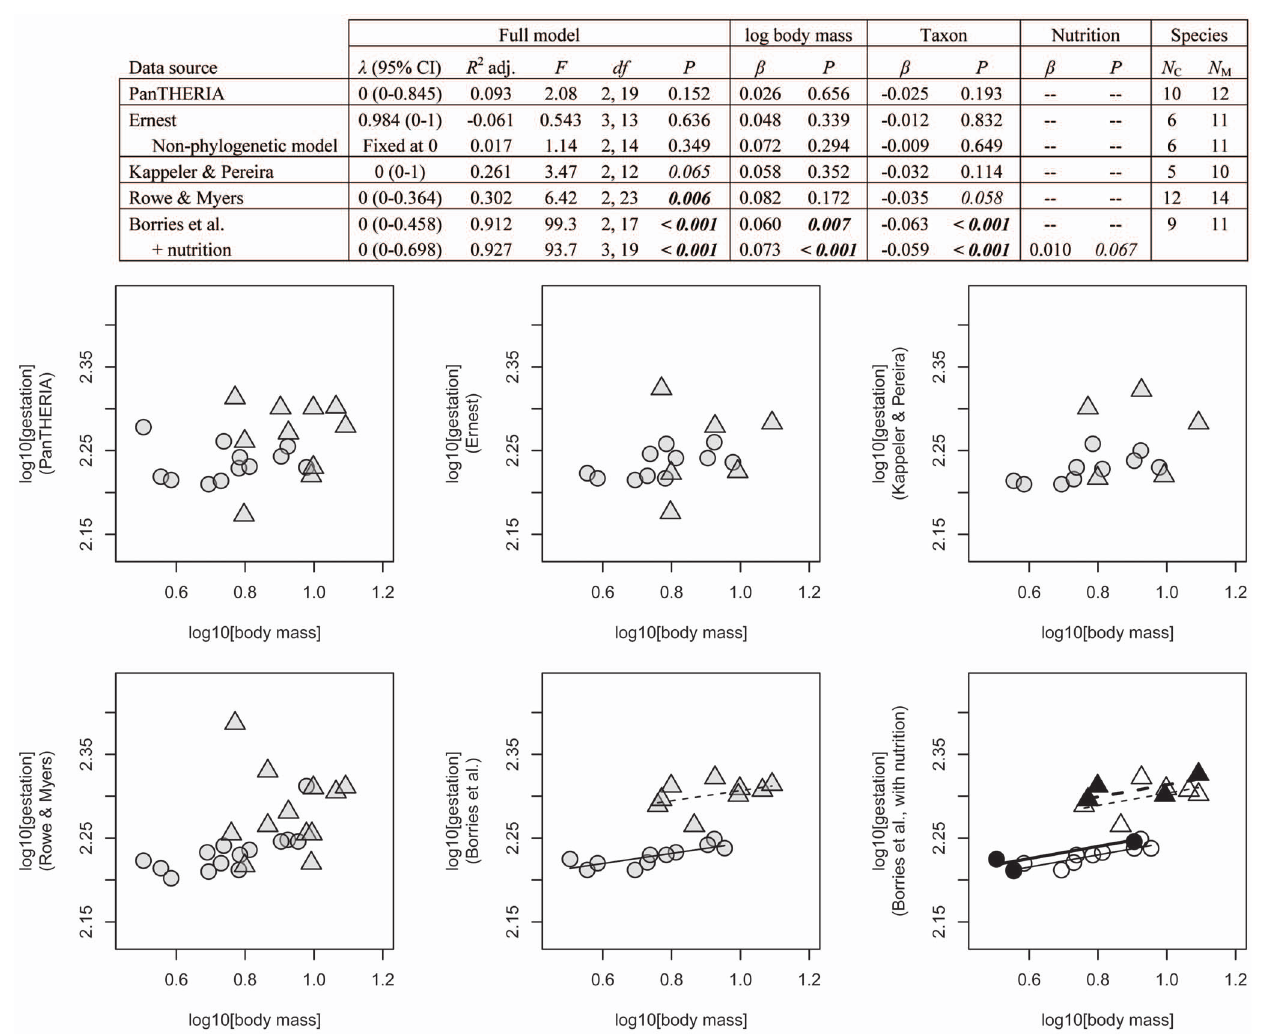
Figure 2. Gestation length [log10 days] in relation to adult female body mass [log10 kg] for different databases. Linear model results and plots for Asian colobines (triangles, dashed lines) and Asian macaques (circles, sold lines); N C =number of Asian colobine species; N M =number of Asian macaque species; –=N/A; bold italic= P # 0.05; italic=0.05 , P , 0.10. Lines only drawn for models with a body mass effect that is significant at alpha=0.05. Where nutrition is included as an independent variable, filled symbols and bold lines stand for wild/unprovisioned whereas open symbols and non-bold lines stand for provisioned/captive. Body mass data from Smith & Jungers [66] and Gordon [67].